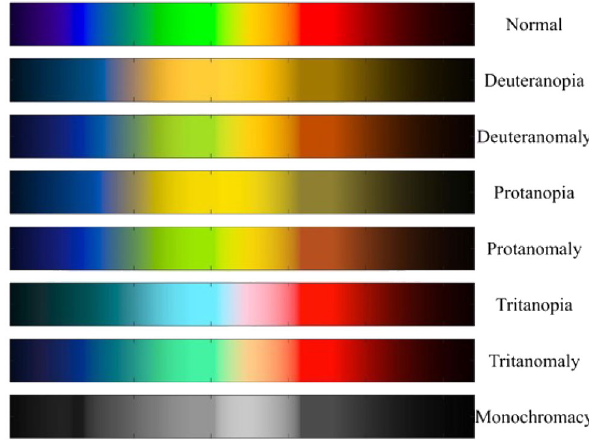
Fig. 2 Top: color spectrum as seen with normal vision. Next 6 rows: the three main types of color blindness paired with their less severe versions. Bottom: monochromatic